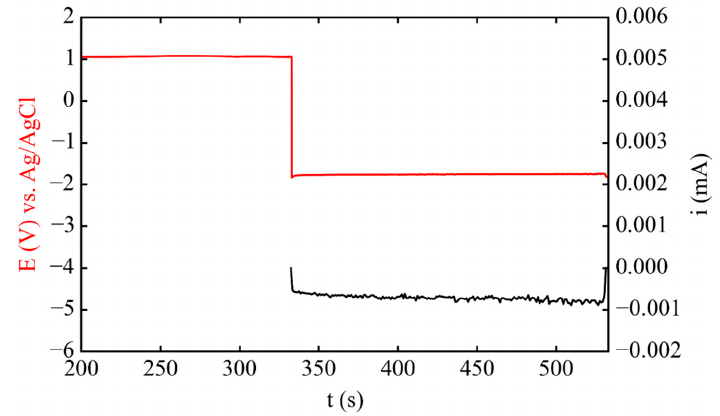
Figure 1. Electrodeposition Pt on Highly Oriented Pyrolytic Graphite (HOPG) (0.36 cm 2 ) in 3 mM H 2 PtCl 6 , 0.5 M NaCl, pH 2.3, under N 2 bubbling and 600 rpm stirring. The time between 200 and 320 s corresponds to the sample immersed at OCP = 1 V vs. Ag/AgCl = 0.8 V vs. NHE. At 320 s, E app = − 3 V vs. CE, which is ca. − 2 V vs. Ag/AgCl and − 2.2 V vs. NHE.